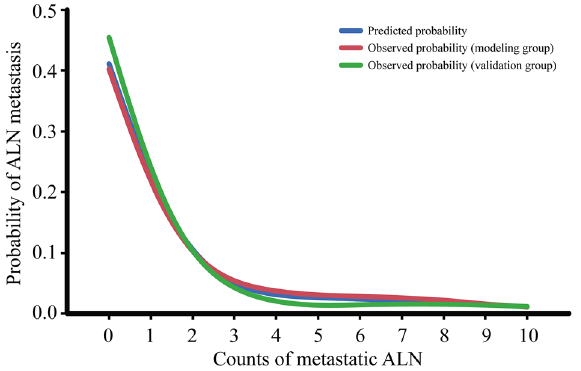
Figure 2. The probabilistic distribution of the negative binomial regression model fitted by the predicted group and observed group. ALN, axillary lymph